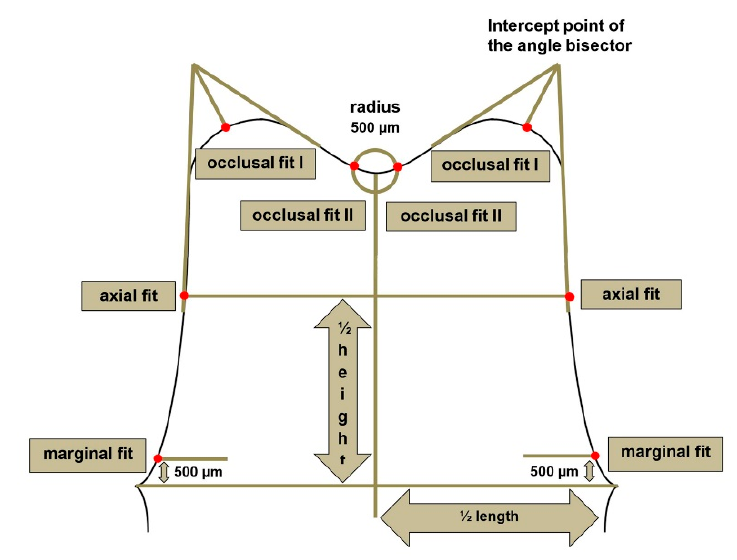
Figure 2. Schematic drawing of the measurement points.